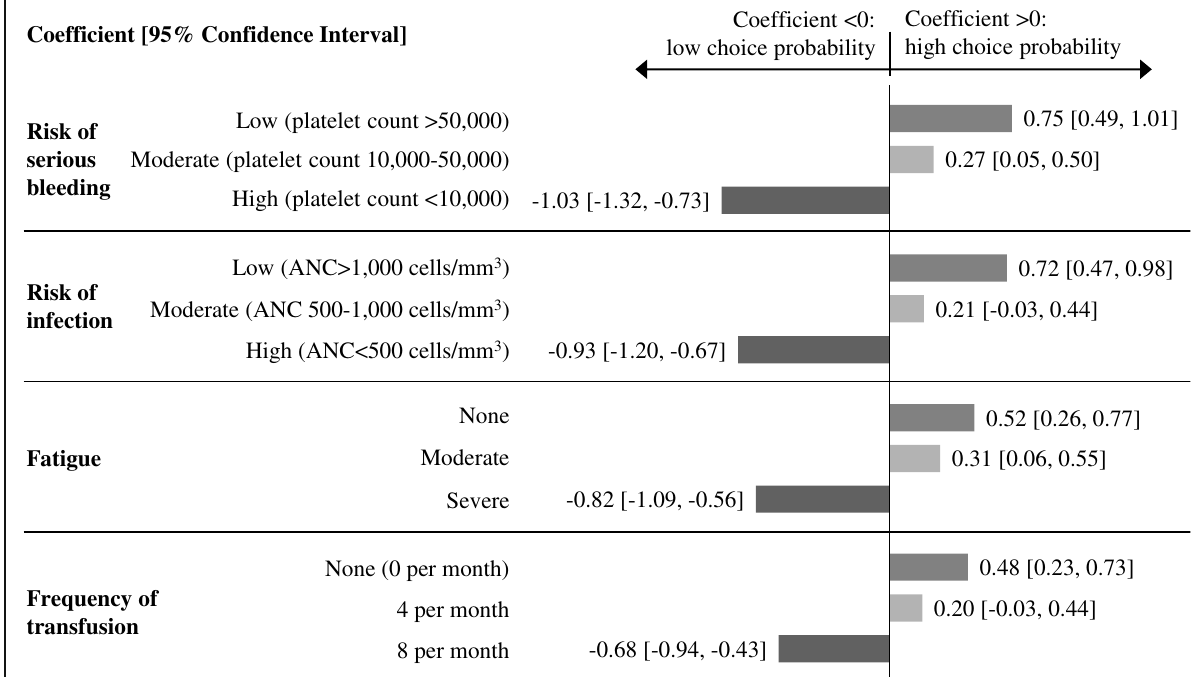
Fig. 3 Effects of attribute levels on health state preference: part-worth utilities ( N = 30). Abbreviation: ANC, Absolute Neutrophil